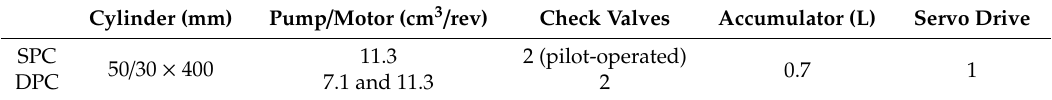
Figure 6. Experimental results of detecting the operation conditions of the arm cylinder. Table 1. Comparison of the components of the SPC and DPC.